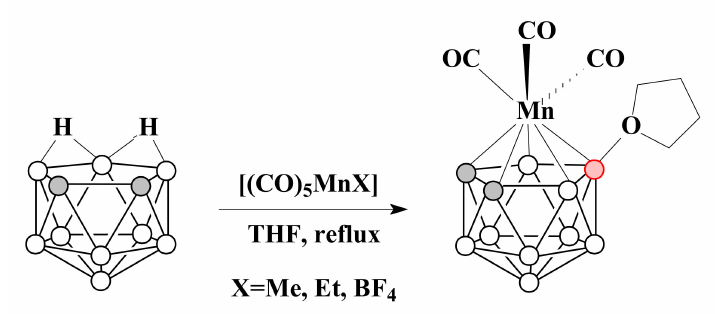
Figure 6. The molecular structure of [3,3,3-(CO) 3 -3-Mn(8-(CH 2 ) 4 O-1,2-C 2 B 9 H 10 )].